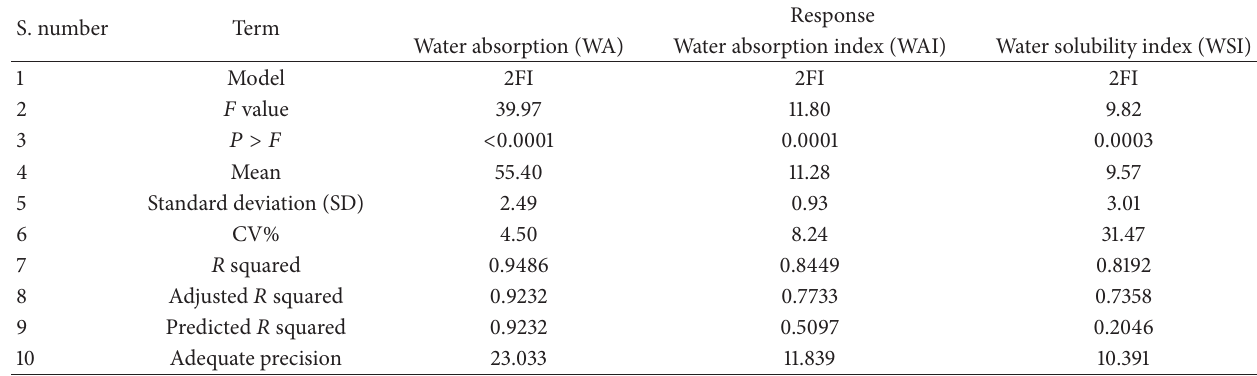
Table 3: ANOVA and model statistics of lotus stem starch.